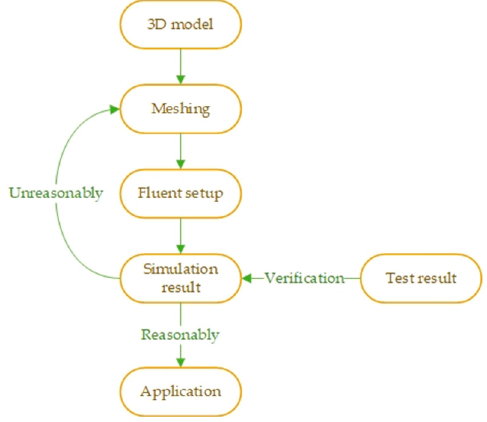
Figure 4. Simulation test process flowchart.